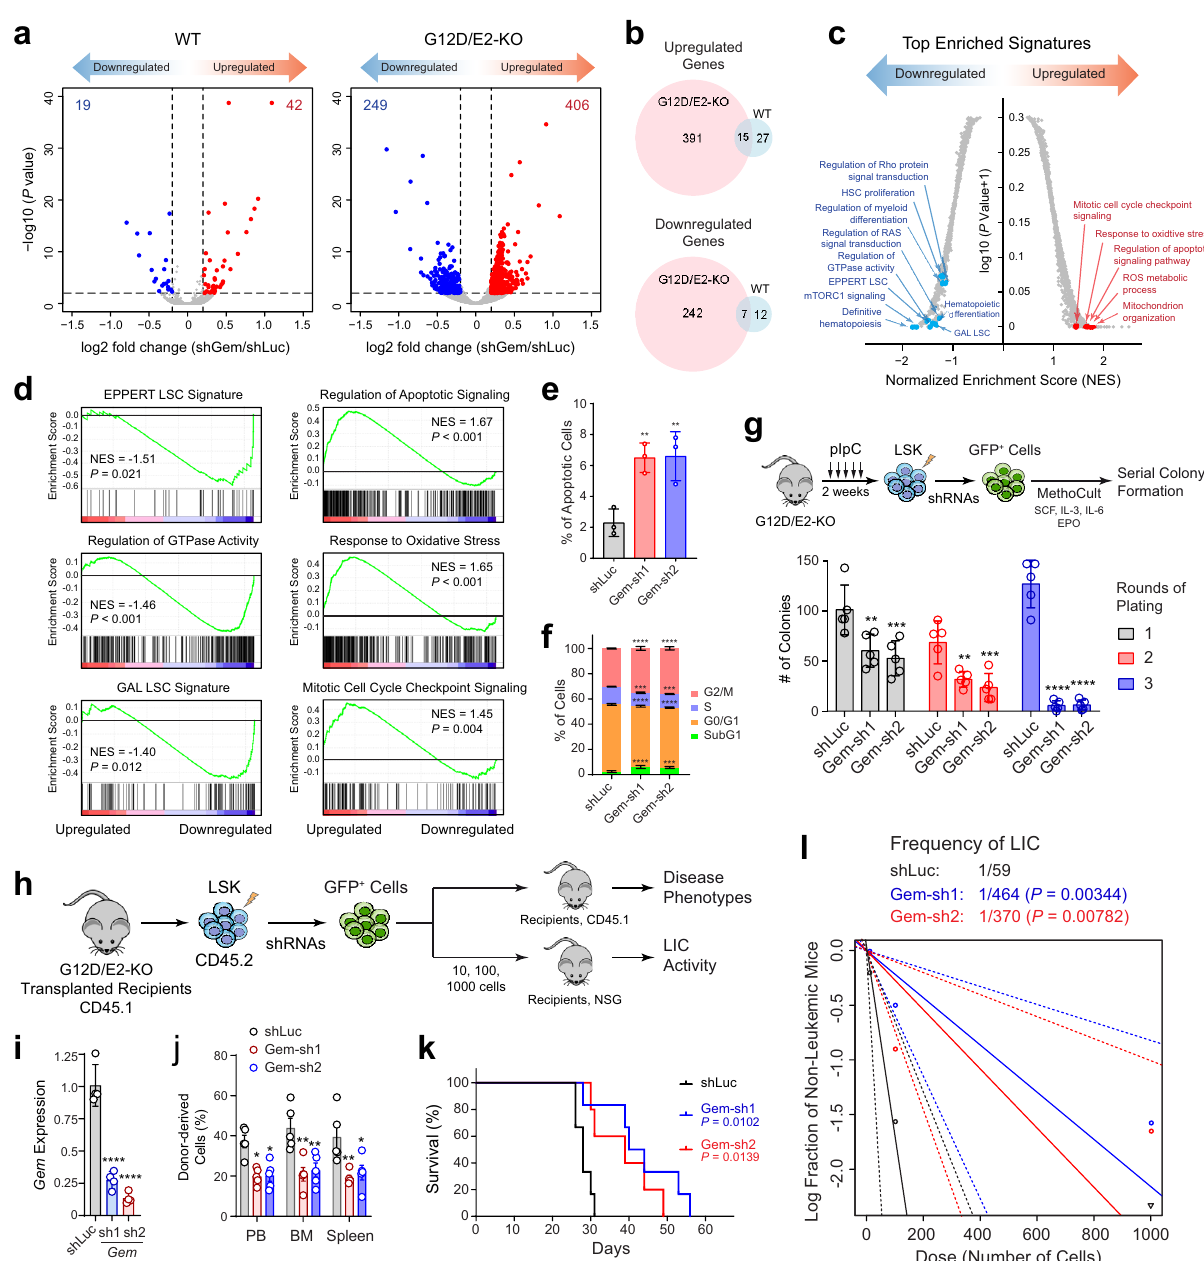
Fig. 7 GEM is a candidate regulator of AML-initiating cells. a Scatterplots of differentially expressed genes in GEM depleted (shGem) relative to control (shLuc) WT or G12D/E2-KO HSPCs. The numbers of downregulated ( blue dots) or upregulated ( red dots) genes are shown. b Venn diagrams of differentially expressed genes overlapped between WT and G12D/E2-KO HSPCs upon GEM depletion. c Top enriched gene signatures upon GEM depletion in G12D/E2-KO HSPCs. d GSEA of top down- or upregulated gene signatures upon GEM depletion in G12D/E2-KO HSPCs. e GEM depletion increased apoptosis (Annexin V + ) in G12D/E2-KO LSK cells. Results are mean ± SD ( N = 3 experiments) and analyzed by one-way ANOVA. ** P < 0.001. f GEM depletion led to cell cycle arrest in G12D/E2-KO LSK cells. Results are mean ± SD ( N = 3 experiments) and analyzed by two-way